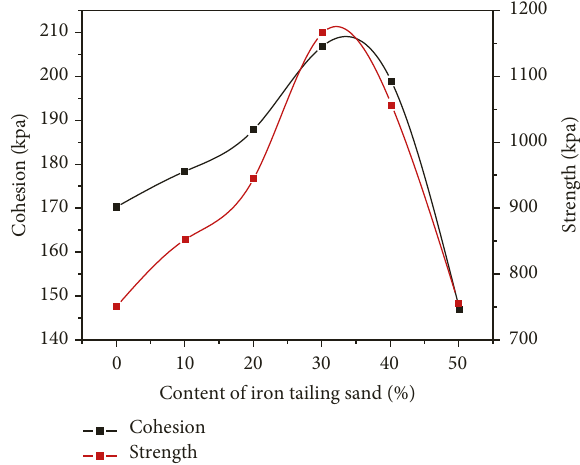
Figure 11: Relationship between dynamic strength parameters and iron tailings sand content.